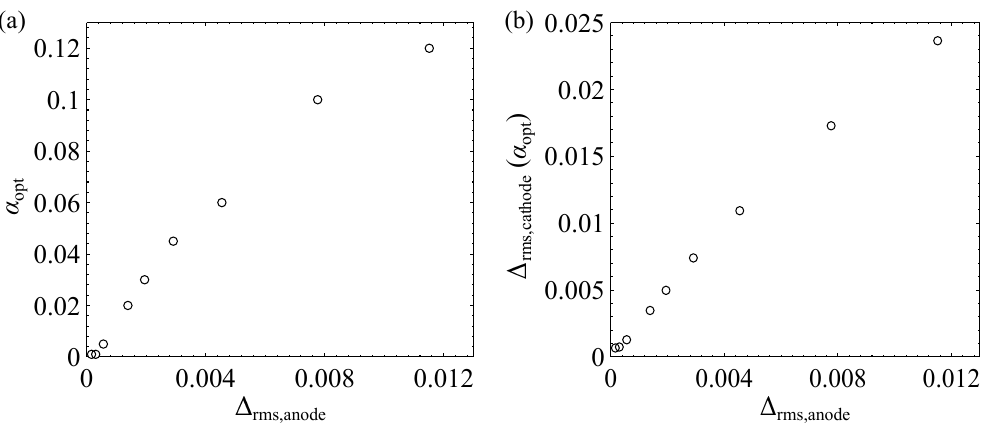
Figure 12. Optimum regularization parameter (Panel ( a )) and error in cathode shape (Panel ( b )) as a function of the error in anode shape. The deviation of the prescribed anode from the ideal anode is varied by varying the number of control points in spline interpolation (cf. Figure